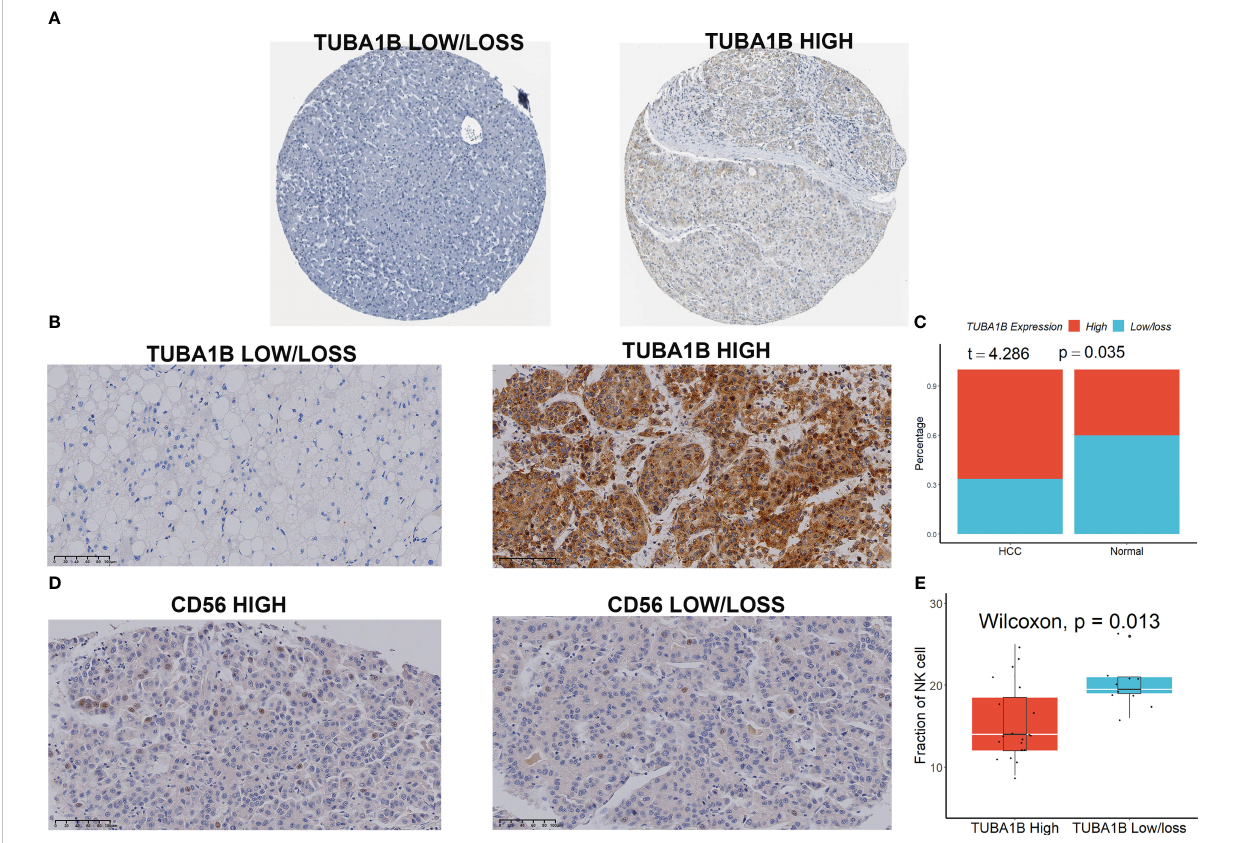
FIGURE 7 TUBA1B expression in HCC. (A) TUBA1B expression explored in HPA database. (B-C) TUBA1B expression explored by IHC in clinical samples. (D) CD56 expression explored by IHC in HCC samples. (E) A lower number of CD56-positive cells in the HCC tissue sections with high TUBA1B